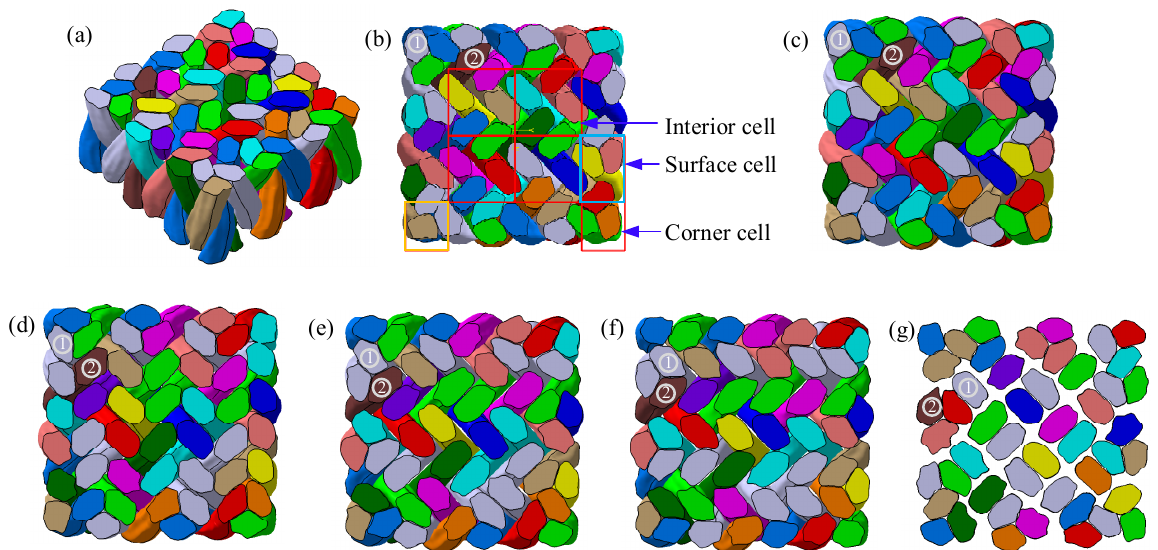
Figure 11. The sequential sections of a 3D4D braiding composite: ( a ) the iso view, ( b ) the top view, ( c ) the ℎ 5 ⁄ section, ( d ) the 2ℎ 5⁄ section, ( e ) the 3ℎ 5⁄ section, ( f ) the 4ℎ 5⁄ section, and ( g ) the 5ℎ 5⁄ section.